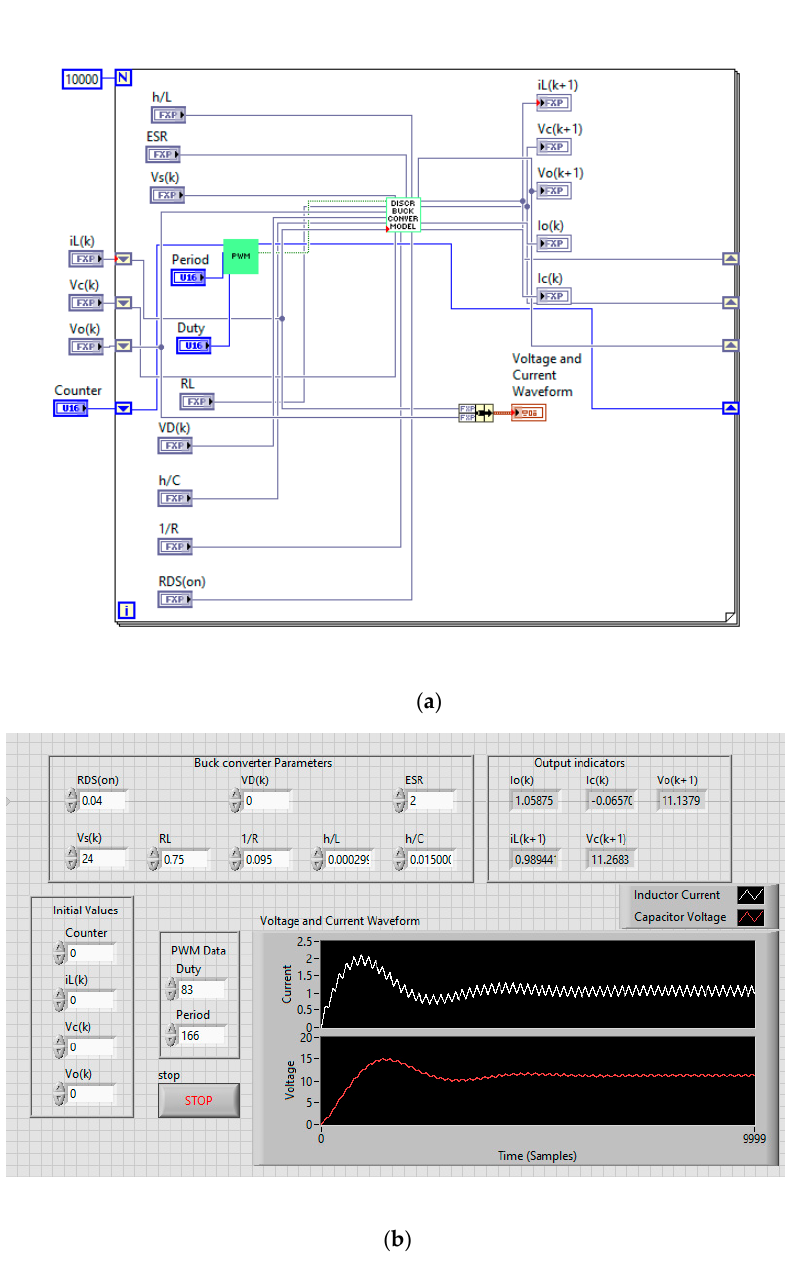
Figure 6. Flow diagram of the off-line simulation of the buck converter.